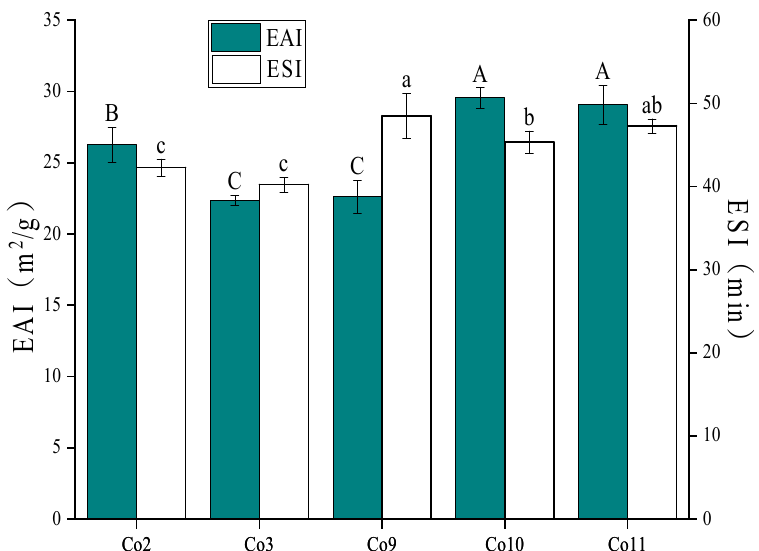
Figure 5. EAI and ESI of Co prepared under different extraction pH conditions. Note: EAI of different samples with different capital letters has a significant difference ( p < 0.05), ESI of different samples with different lowercase letters has a significant difference ( p < 0.05).